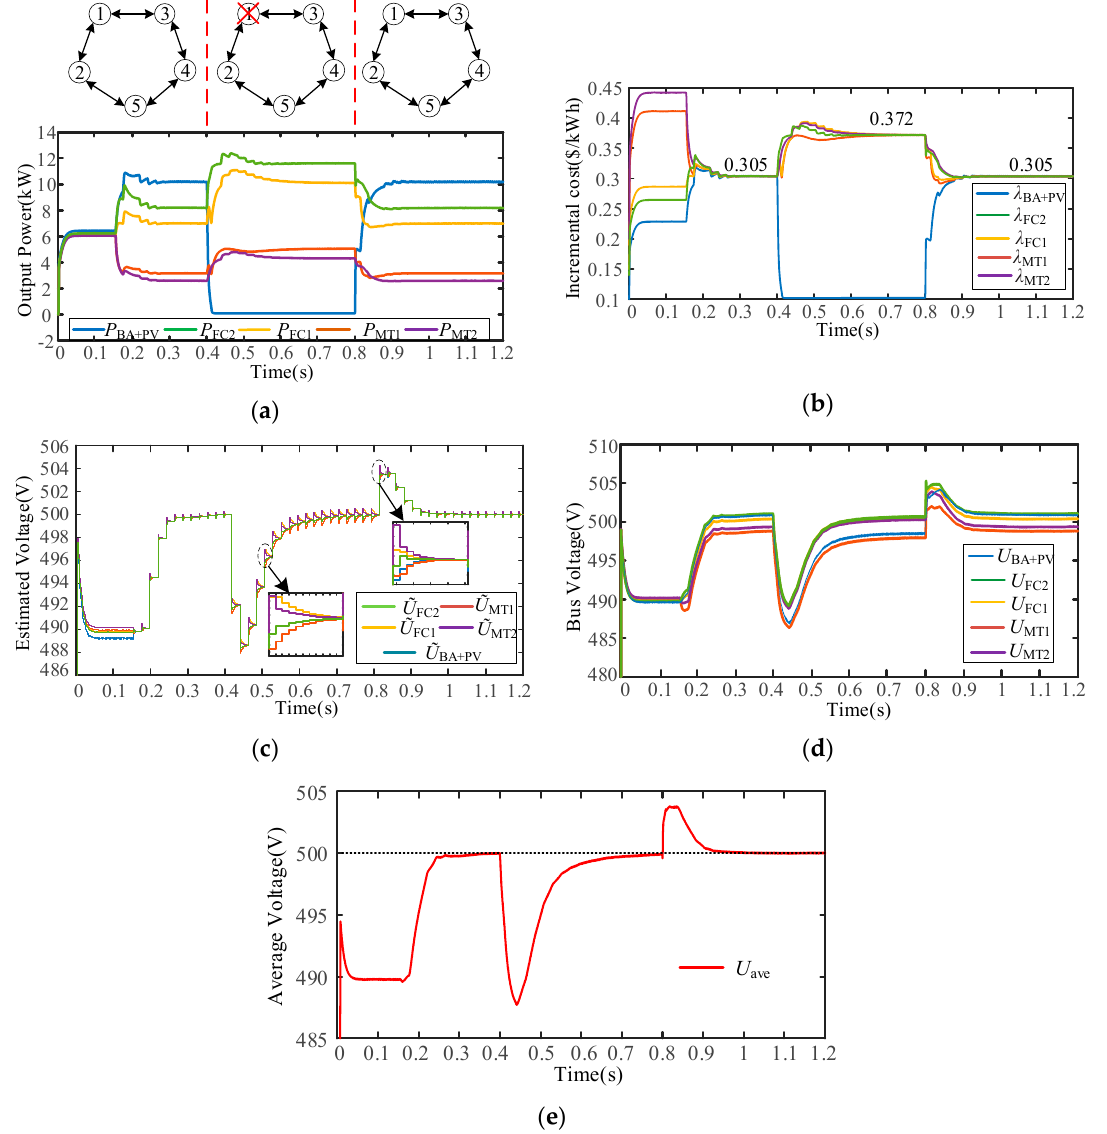
Figure 14. Plug and play performance of the proposed scheme. ( a ) the output power of each generator; ( b ) the incremental cost of each generator; ( c ) the estimated voltage in each voltage regulator; ( d ) the bus voltages; ( e ) the average voltage of the system.